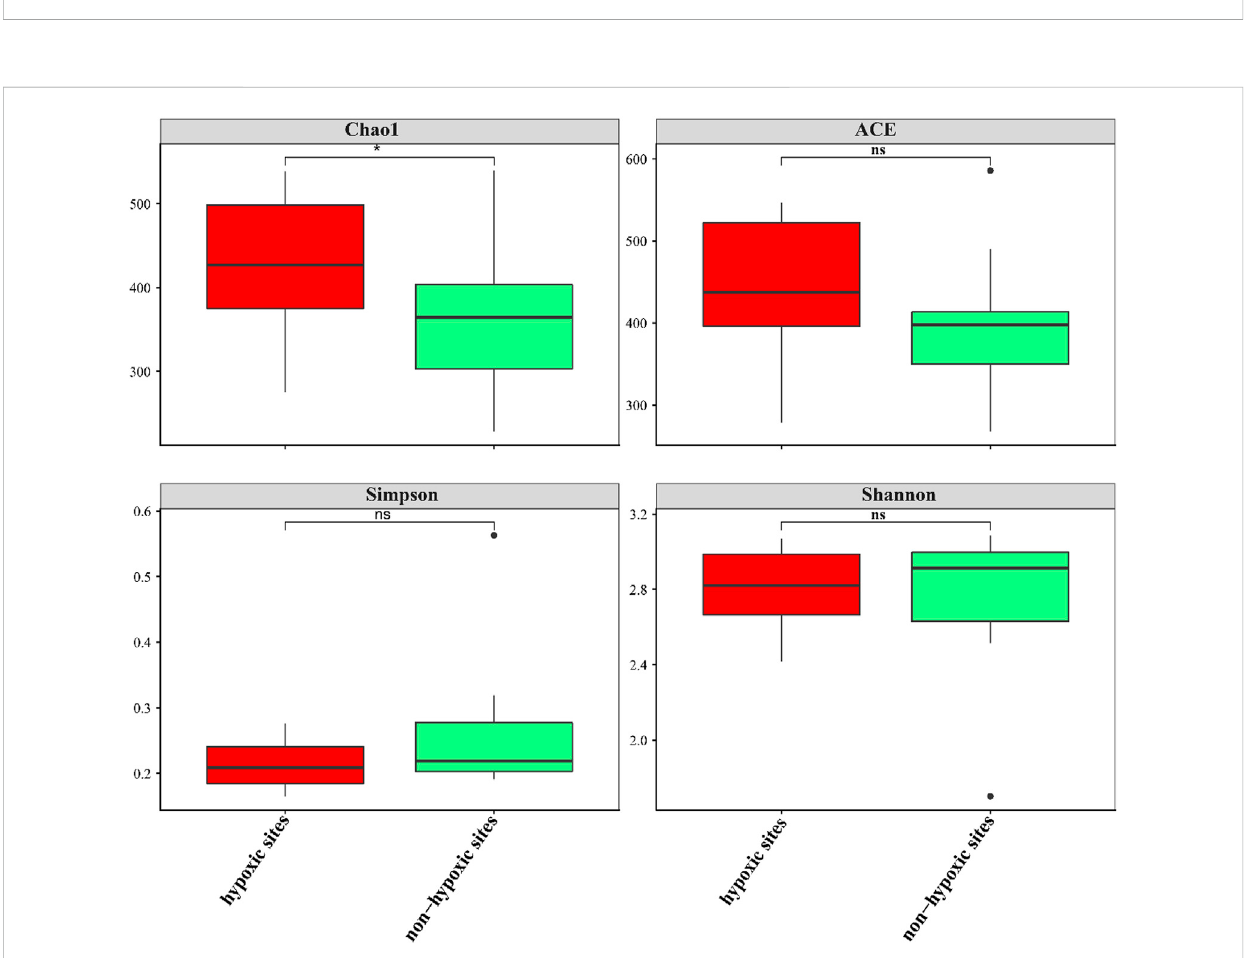
FIGURE 4 Box plots of the alpha diversity of the archaeal communities between the hypoxic and non-hypoxic